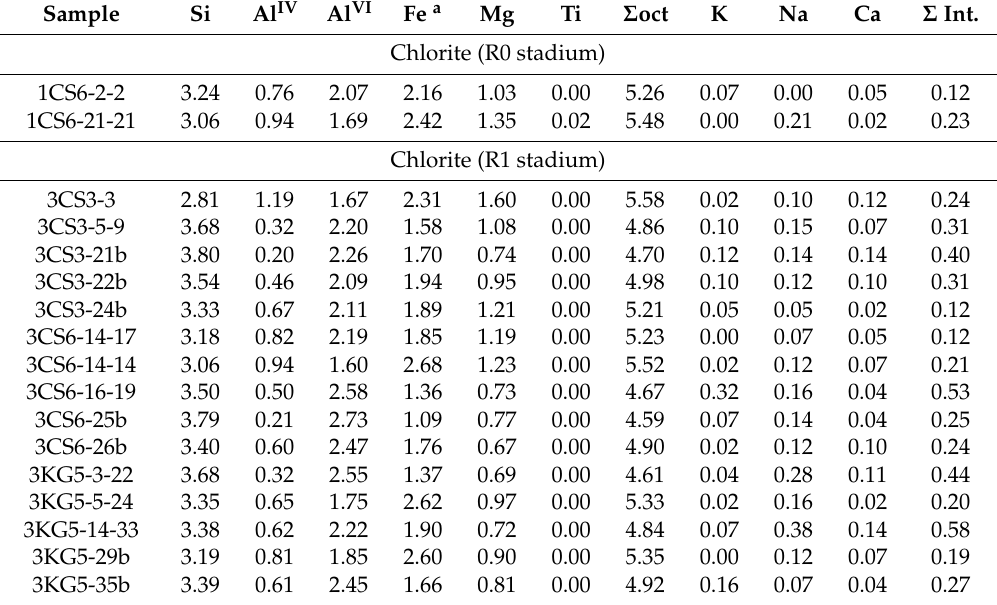
Table 2. Chemical composition of chloritic phases determined by